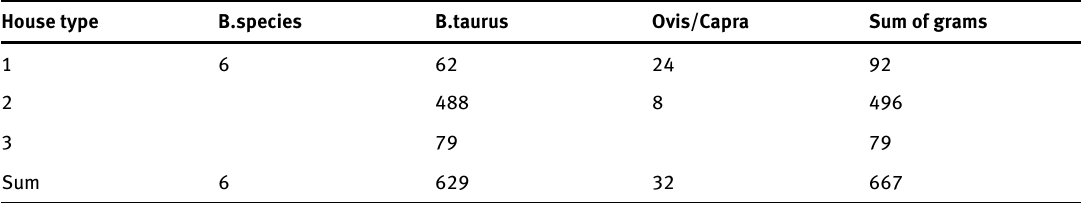
Table 1a: Bylany (distr. Kutná Hora), pottery phases 1 to 8. Amount of animal bones in house types. Data after Peške,Rulf , Slavíková (1998).